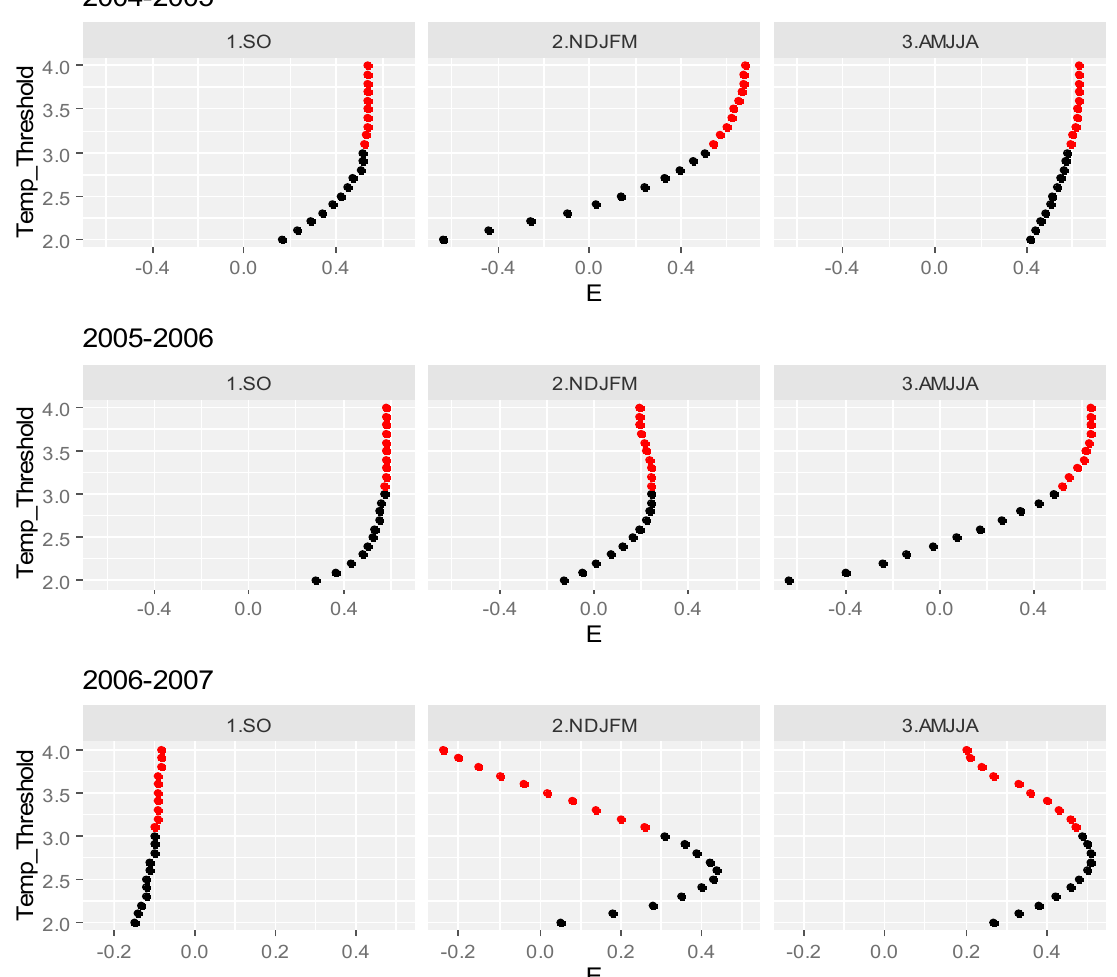
Figure 7. Seasonal threshold temperature rain/snow T0 sensitivity for the three hydrological years in terms of its effect on E . Red points show the points located above 3 ◦